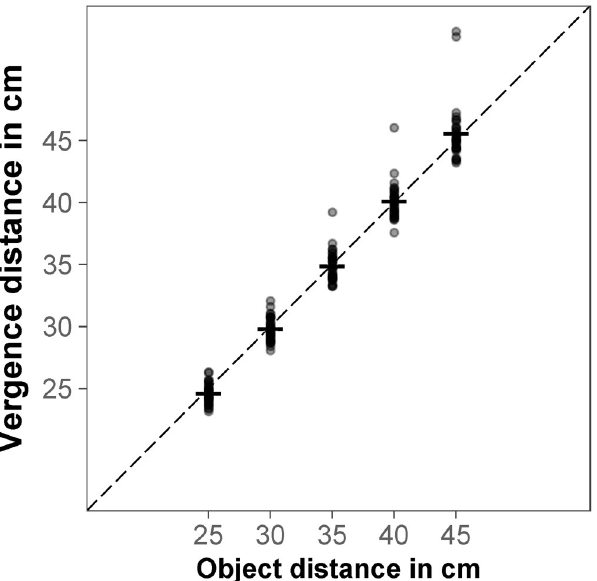
Fig 8. Vergence distance in congruent trials. Mean vergence distance for object distance; each data point represents the median for one participant (aggregated over six objects); the dashed black line represents the object distance as specified by binocular disparity and familiar